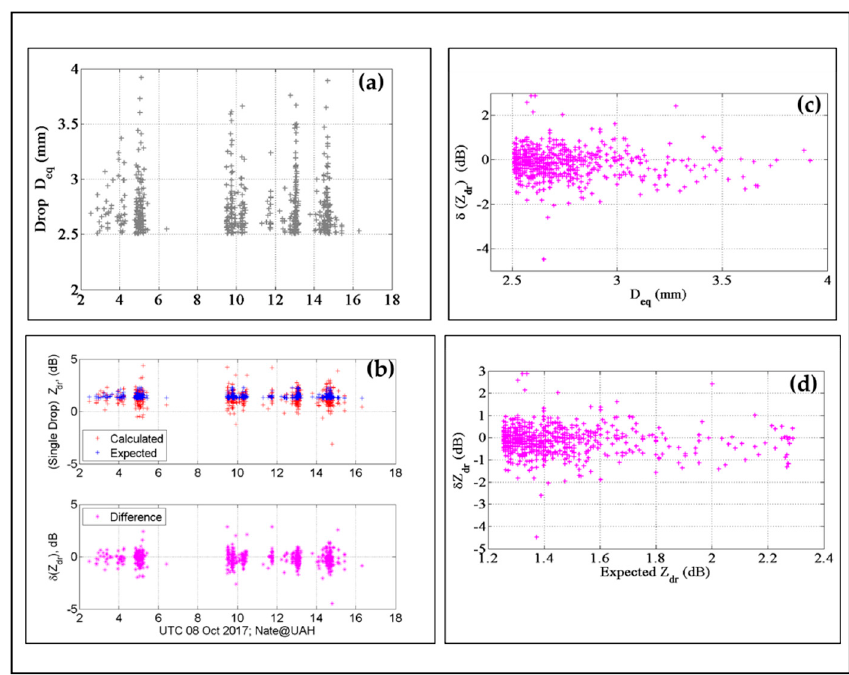
Figure 6. ( a ) Diameters of all drops >2.5 mm recorded during the passage of the outer rain bands of tropical depression (TD) Nate over the 2DVD; ( b ) (top panel) the calculated Z dr for each 3D ‐ reconstructed drop in red and the expected Z dr for each drop (in blue), assuming the oblate axis ratio of Thurai et al., and δ Z( dr ) for each particle (bottom panel); ( c ) δ (Z dr ) versus D eq ; ( d ) δ (Z dr ) versus the expected Z dr .